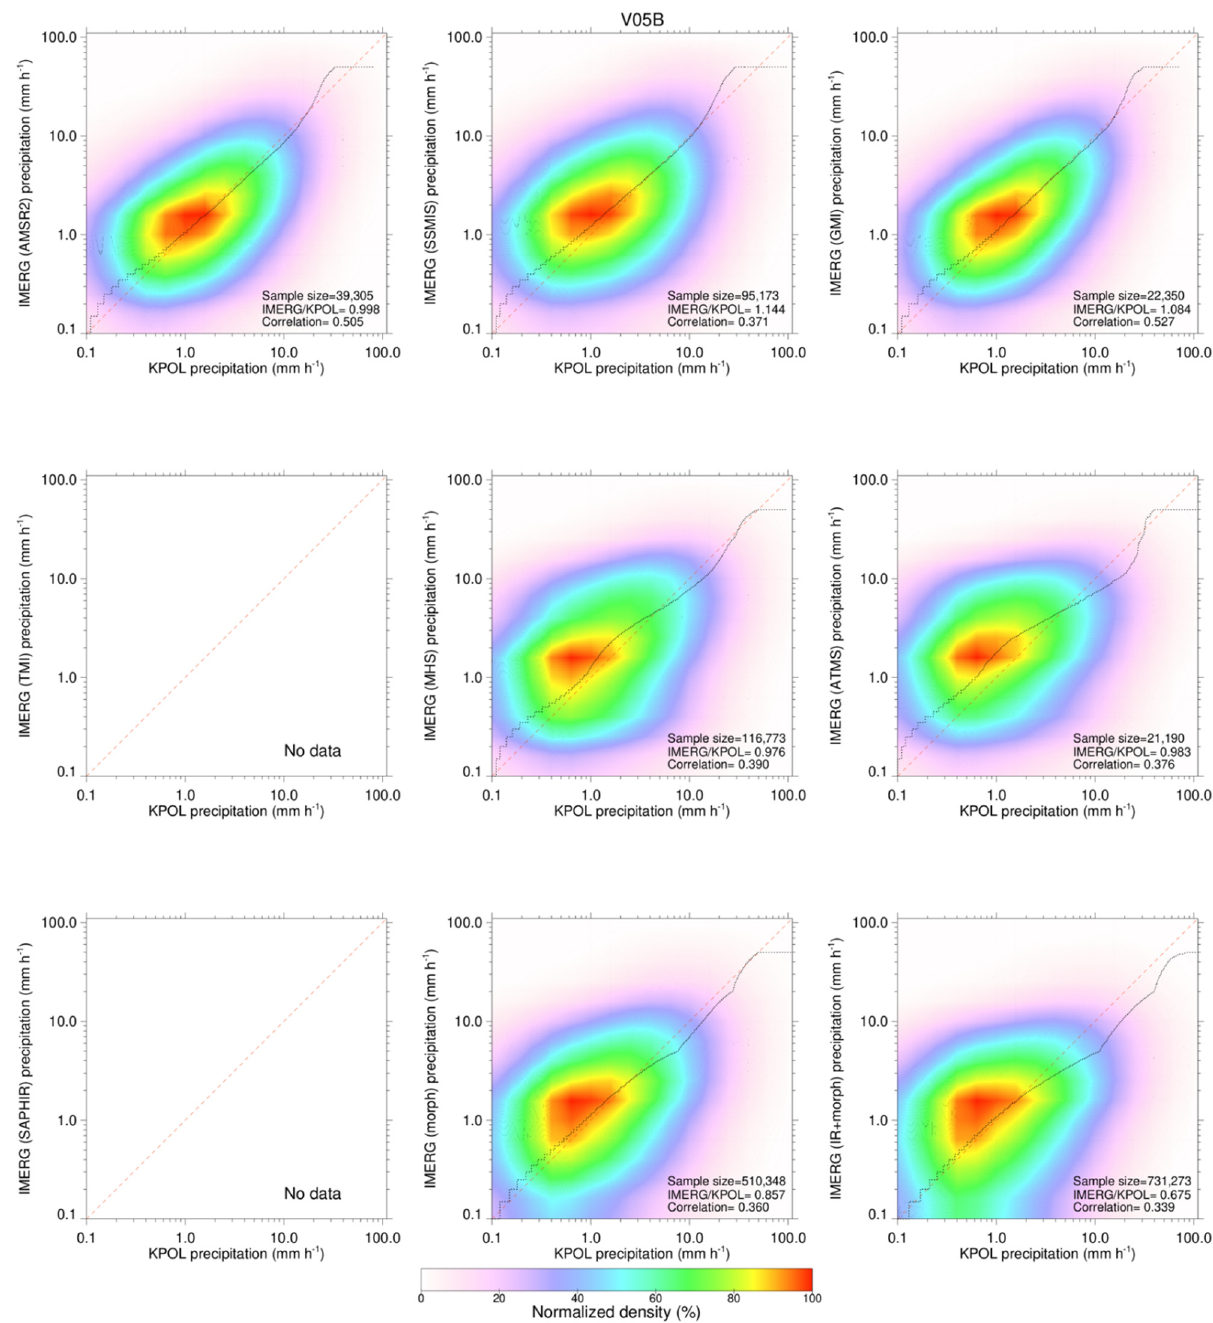
Figure 10. Joint distributions of half-hourly precipitation rates at 0.1 ◦ resolution from IMERG V05B against KPOL, conditional on both precipitation rates at least 0.1 mm h − 1 . The black dotted line denotes the quantile–quantile match-ups, and the diagonal red dashed line indicates 1:1